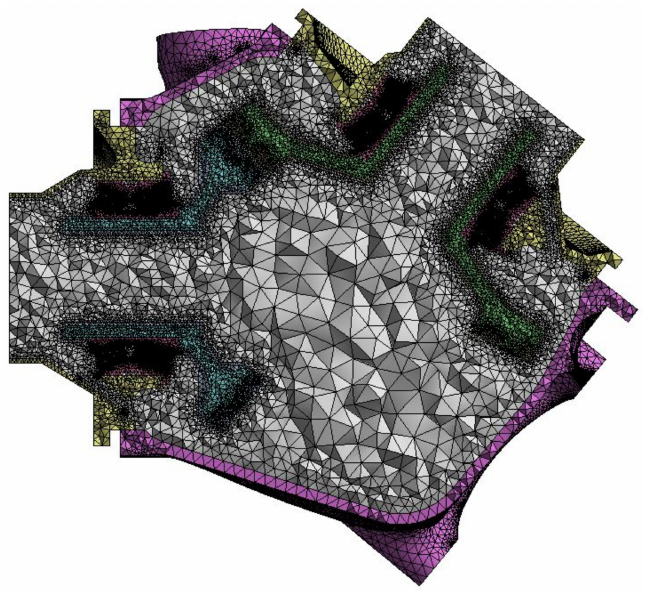
Figure 7. Mesh diagram for thermal-fluid coupling computational